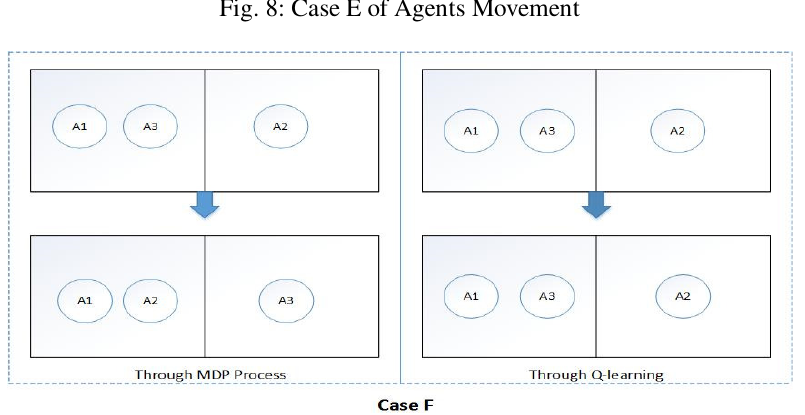
Fig. 9: Case F of Agents